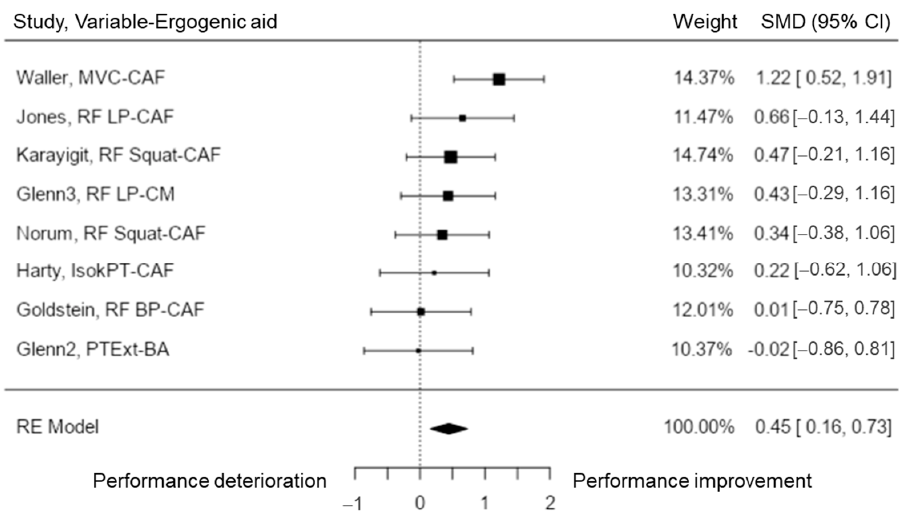
Figure 4. Resistance strength performance forest plot . MVC = maximal voluntary contraction; RF = repetitions until failure; LP = leg press; PT = peak torque; Isok = isokinetic; Ext = extension.